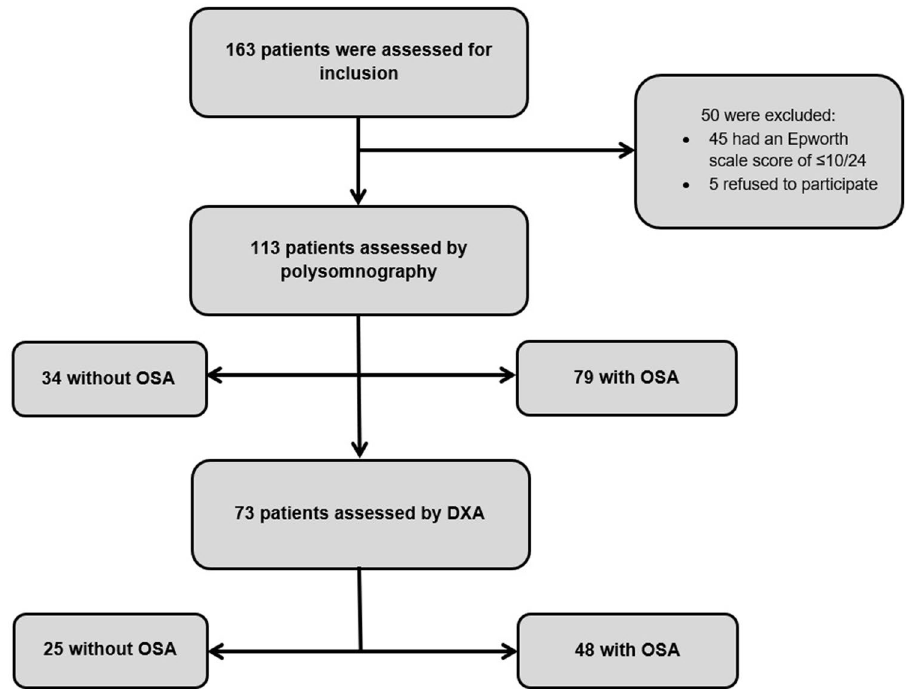
Figure 1. Flow-chart of the study